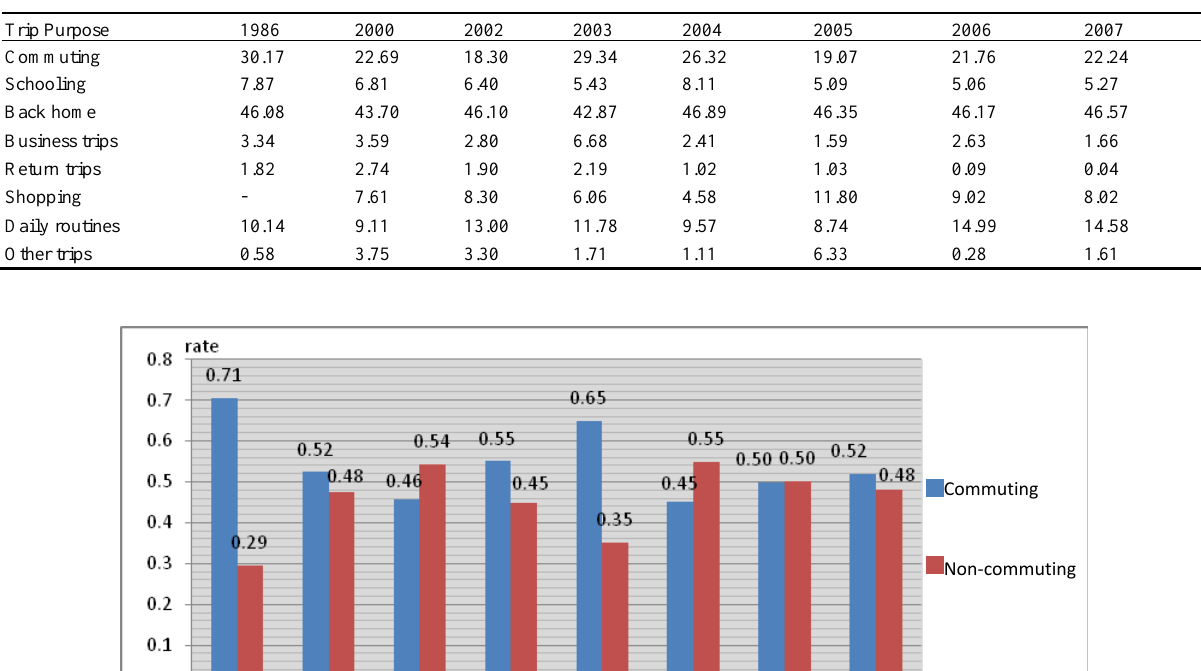
Table 5: Trip purpose of Beijing residents from 1986 to 2007 （ % ）